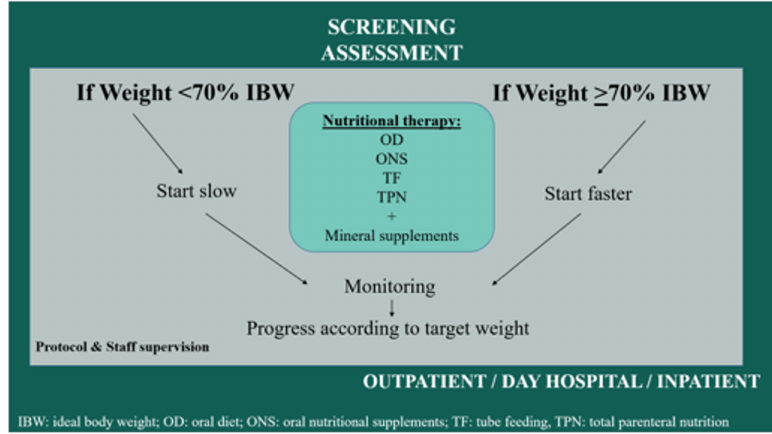
Figure 1. Algorithm of the nutritional treatment in